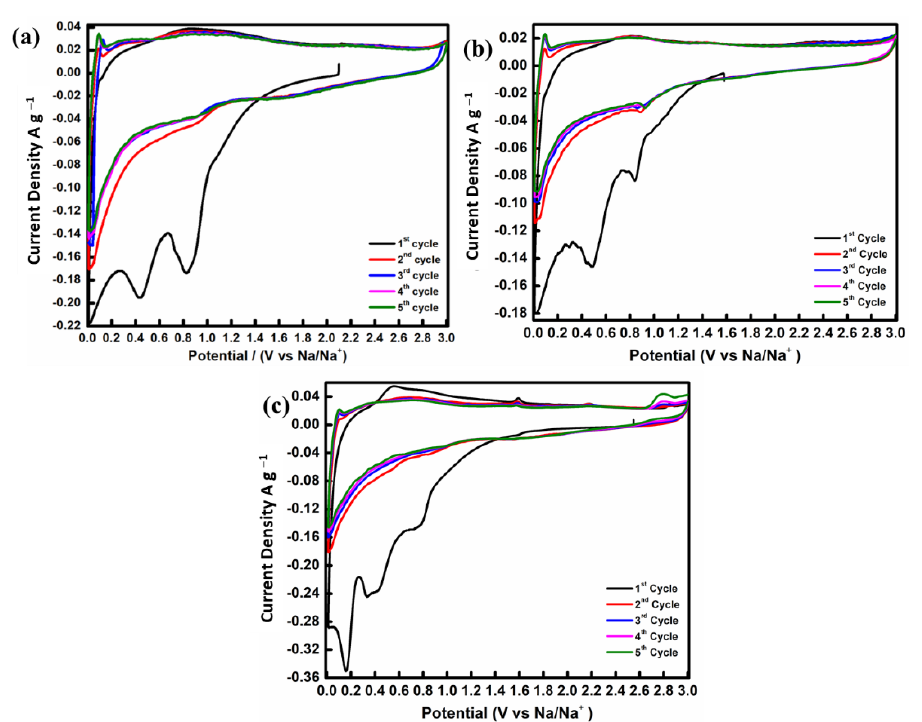
Figure 8. CV curves of ( a ) Mn 3 O 4 nanoparticles, ( b ) Mn 3 O 4 /N-rGO aerogel, and ( c ) Mn 3 O 4 /N,S-rGO aerogel at a scanning rate of 0.1 mV s − 1 .